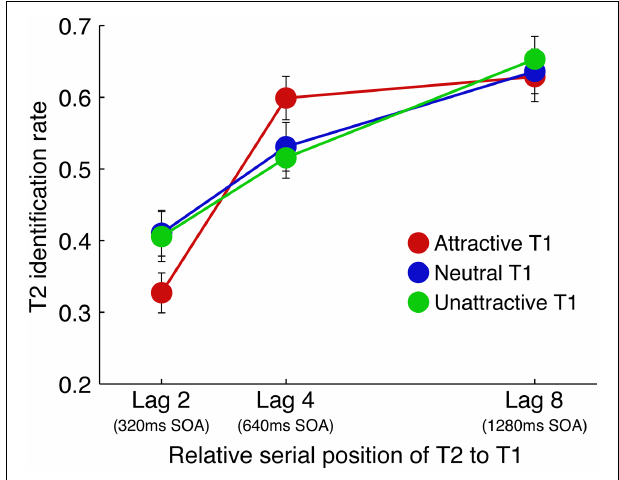
FIGURE 2 |T2 identification rates for each attractiveness category by time lag. Error bars represent SE of the mean.